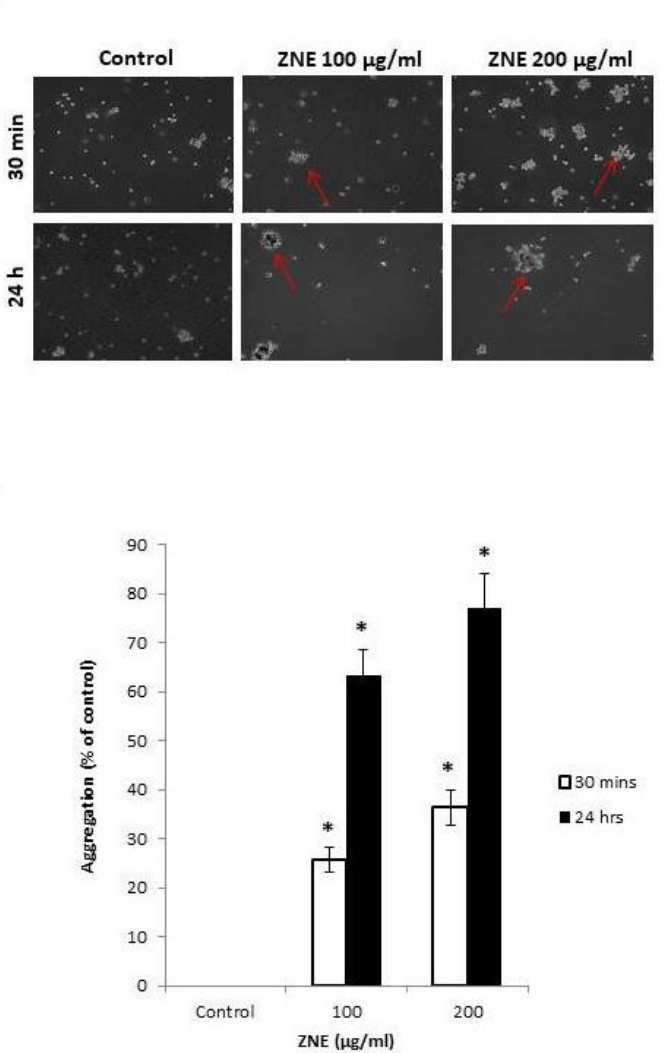
Figure 7. Ziziphus nummularia promotes cell–cell aggregation of Capan-2 cells. Capan-2 cells were incubated without or with the indicated concentrations of ZNE and subjected to cell aggregation as described in Materials and Methods. ( a ) Micrographs of the cells were then taken at 10 × magnification. ( b ) Percentage of aggregation was calculated using the following equation: % aggregation = (1 − Nt/Nc) × 100, where Nt and Nc represent the number of single cells in ZNE-treated or control groups, respectively. * denotes a p < 0.05, compared to control values at the respective times.